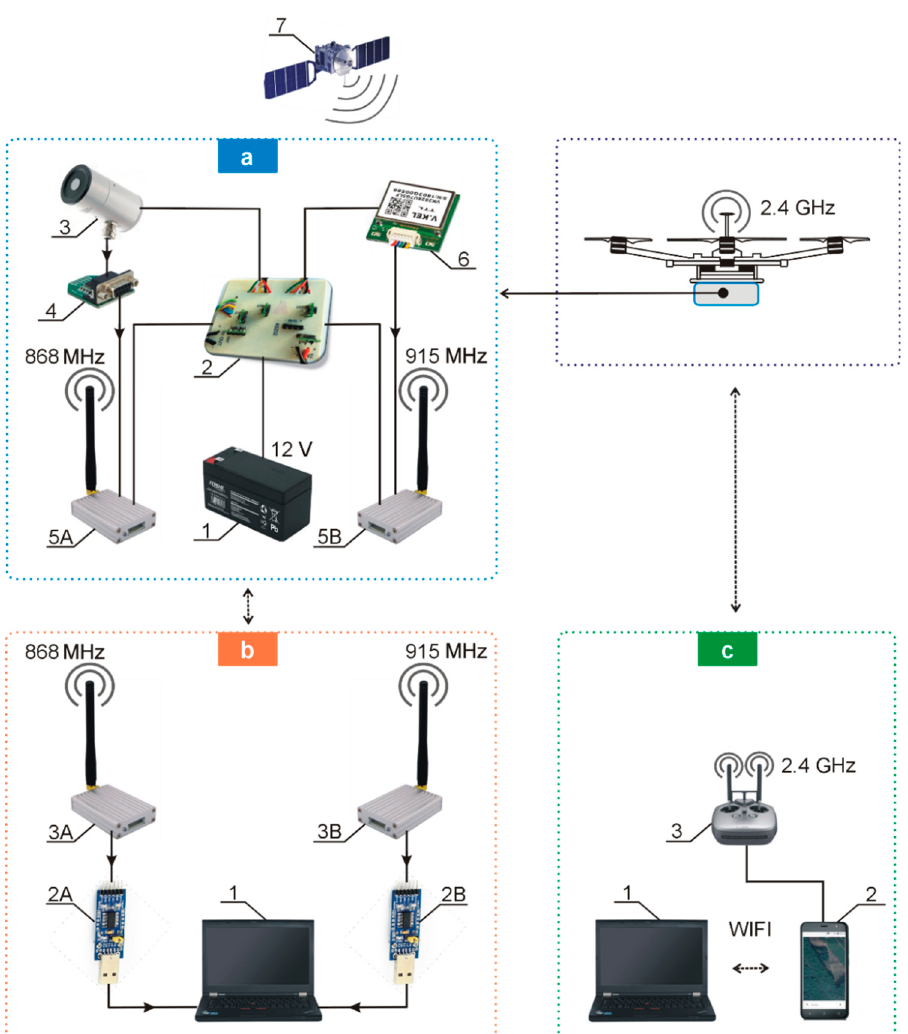
Figure 2. Explanatory wiring diagram of individual components: block ( a ) 1, battery; 2, printed circuit board with voltage converters installed; 3, illuminance meter; 4, RS232/UART adapter connecting the illuminance meter with the RS232 connector with the RF transmitter equipped with the URT connector; 5, transmitters; 6, GPS module; 7, satellite. Block ( b ) 1, PC computer; 2, UART/USB converter; 3, receivers. Block ( c ) 1, PC; 2, smartphone with software installed; 3, UAV controller.